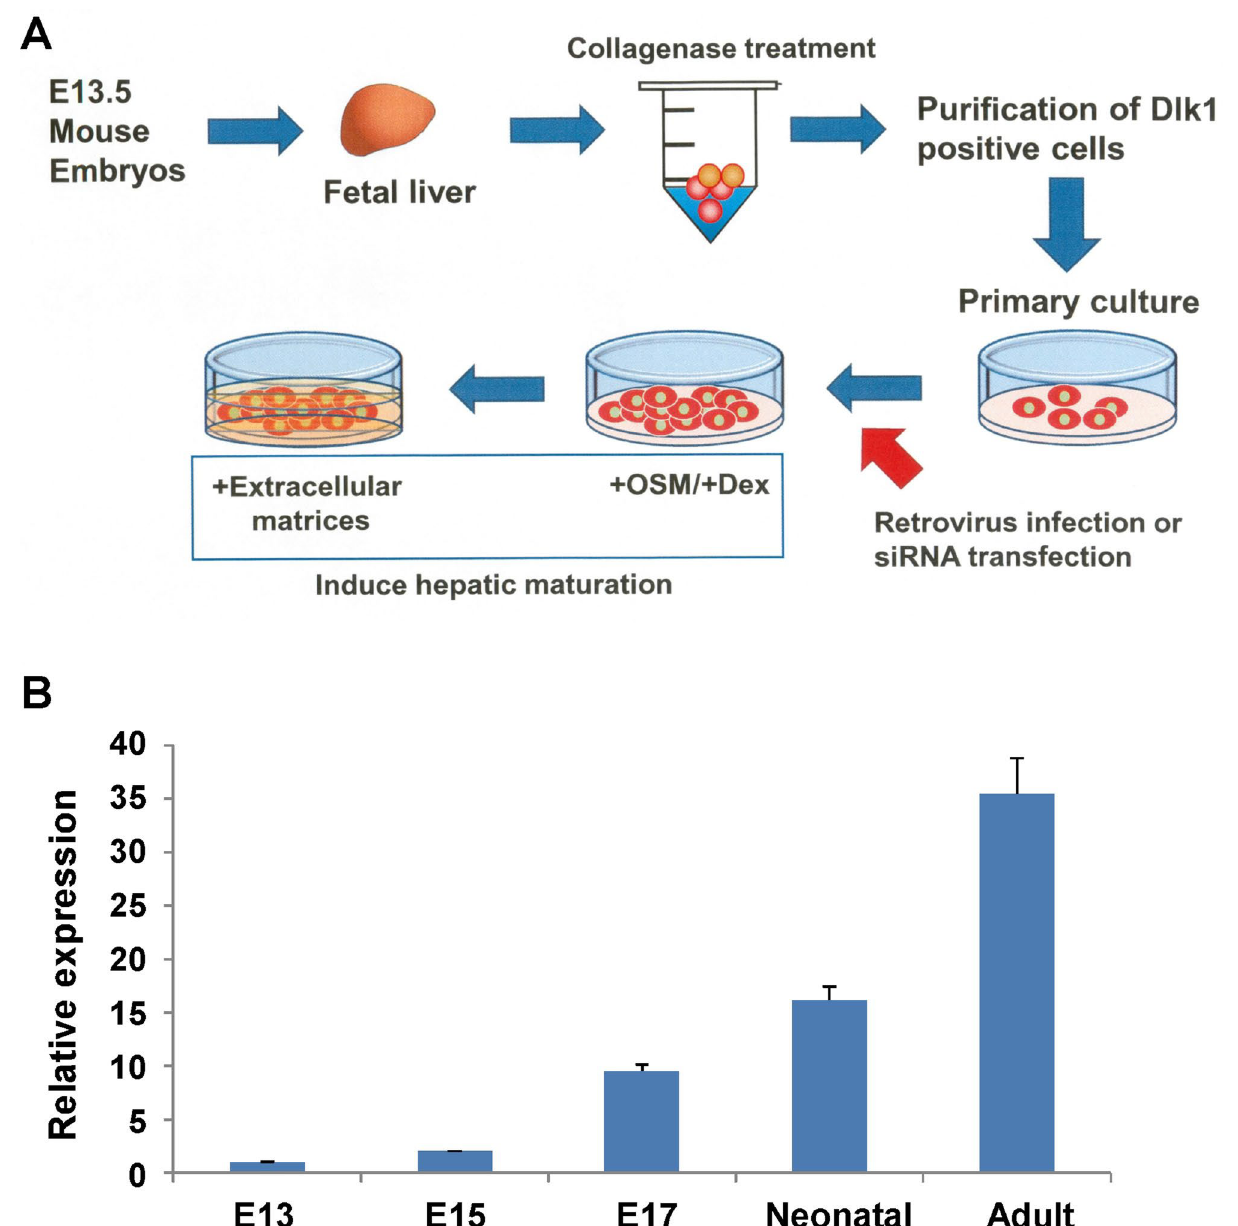
Figure 1. Screening of transcriptional factors that regulate mature liver function. ( A ) The schema of screening system for liver functional factors. Dlk1-positive primary hepatoblasts were purified and cultured on gelatin- coated dishes. Transcription factors were overexpressed using the retroviral vectors. After induction of hepatic maturation by oncostatin M (OSM) and Matrigel, the expression of Tat , a liver function gene, was evaluated by quantitative reverse transcription-polymerase chain reaction (RT-PCR). ( B ) The expression of Kruppel-like factor 15 ( Klf15 ) in fetal and adult whole livers was analyzed using quantitative RT-PCR. Total RNA was purified from samples derived from embryonic day 13, 15, 17 (E13, E15, E17), neonatal, and 8-week-old adult male livers. Hprt was used as an internal control. Expression of Klf15 in E13 mouse livers was set to 1.0. Results are represented as the mean ± standard deviation (SD) (n = 4). *P <